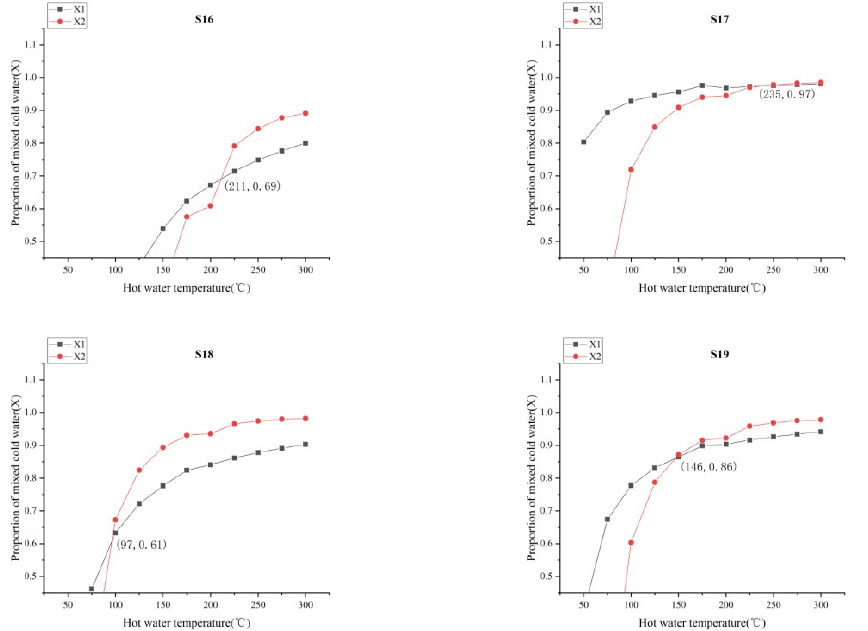
Figure 11. Diagram of hot spring hot and cool water mixing ratio in the study area, based on the silicon enthalpy equation method. X 1 is the mixing ratio of each enthalpy value calculated at various assumed initial temperatures of hot water; X 2 is the mixing ratio of each SiO 2 concentration calculated at various assumed initial temperatures of hot water; S1 − S19 represents the number of hot spring samplings.